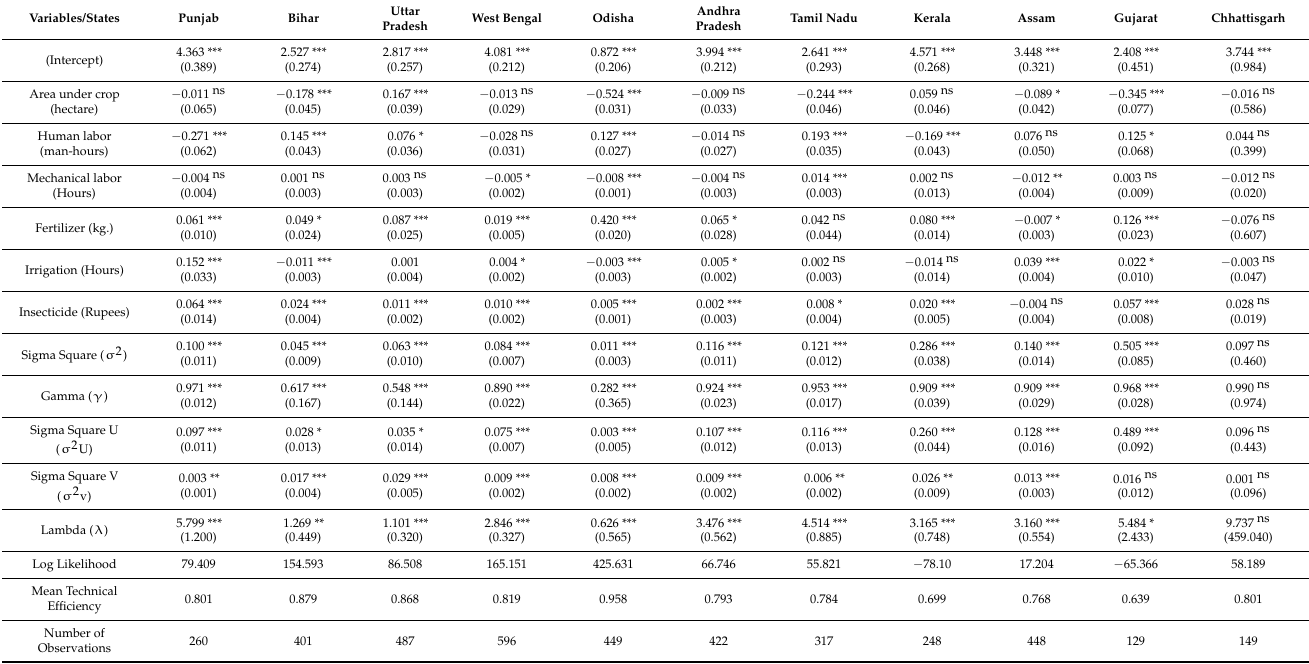
Table 7. Maximum likelihood estimates for the Cobb–Douglas type stochastic frontier production function for major paddy cultivating states in India for the AY